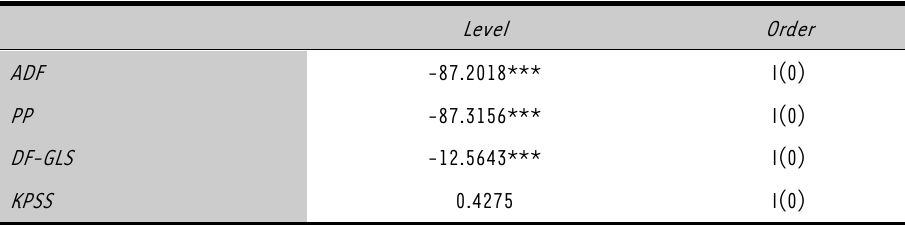
Unit root tests for stock return series Level Order ADF -87.2018*** I(0) PP